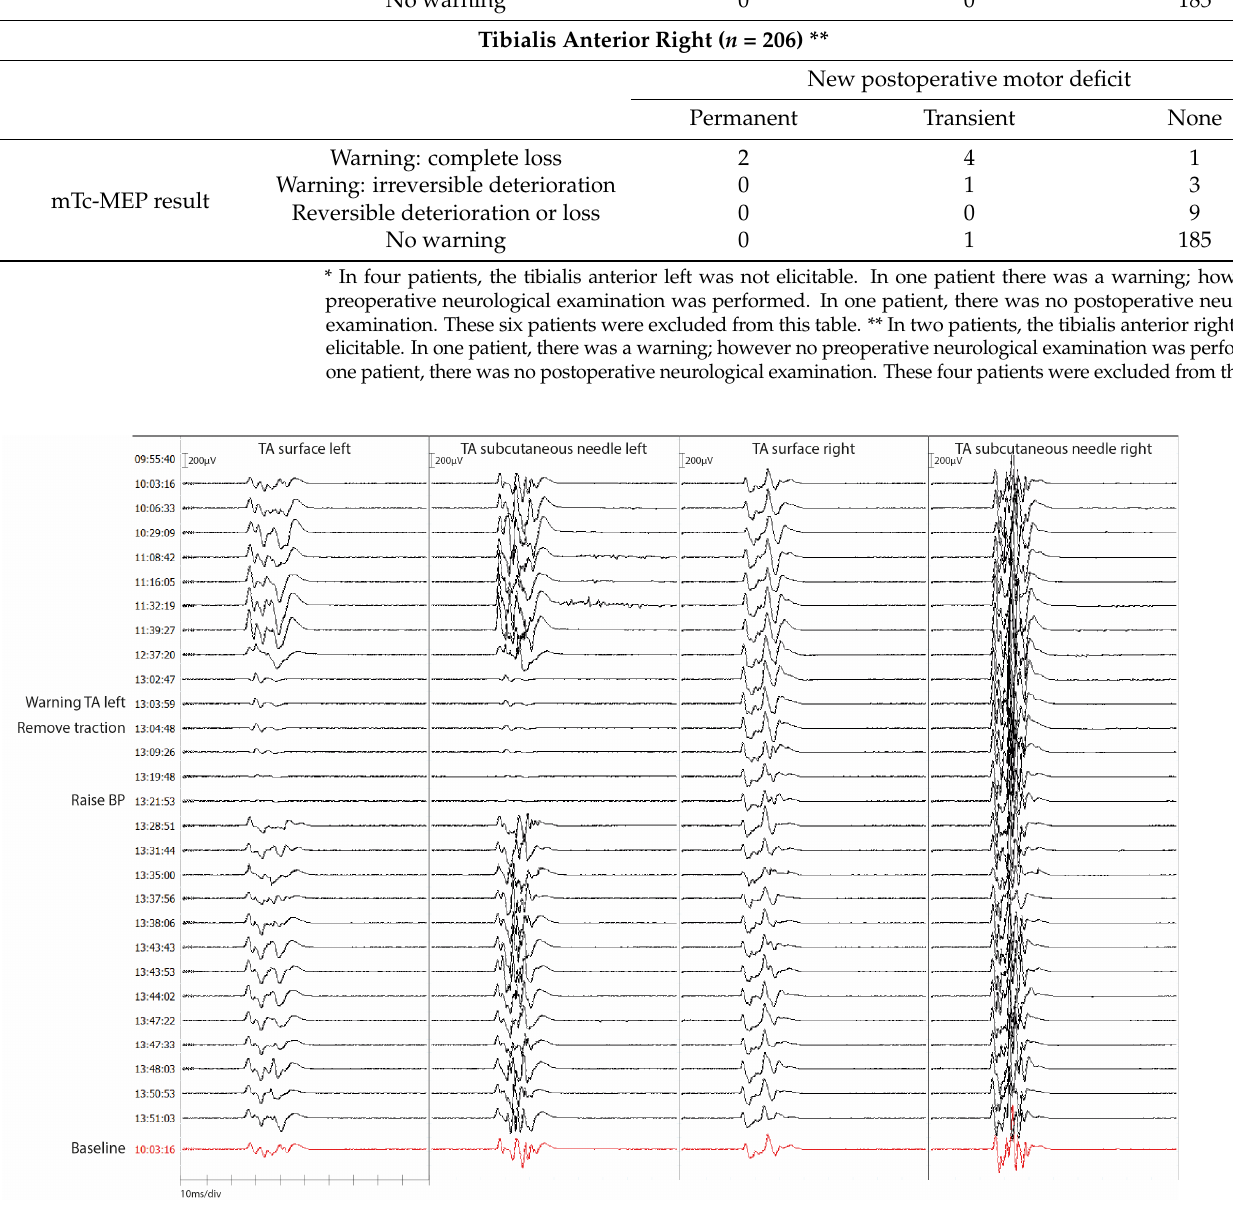
Figure 3. Case example of a reversible mTc-MEP warning for both surface and subcutaneous needle recording electrodes. A case example of patient 19 of Table 4. mTc-MEPs are recorded for the left and right TA with both surface and subcutaneous needle recording electrodes. The 15-year-old pa- tient underwent scoliosis correction surgery by an anterior retroperitoneal approach due to a con- genital hemivertebrae of S1. Preoperative left and right TA strength was intact (MRC 5). The left TA